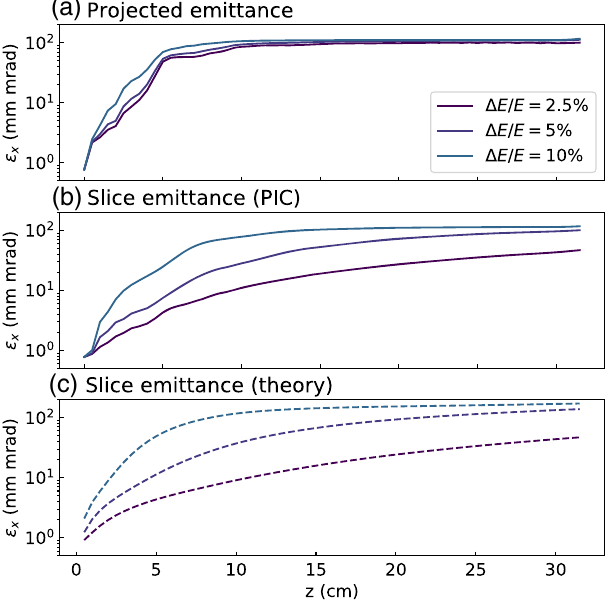
FIG. 8. Emittance growth for various energy spreads. Simu- lation conditions are given in Table I. The laser pulse propagates on axis, and the electron beam starts with a 10 μ m transverse offset. (a) – (c) show, respectively, the PIC projected emittance, the PIC slice emittance, and the theory for slice emittance. The energy spread is 2.5%, 5%, and 10%, respectively.